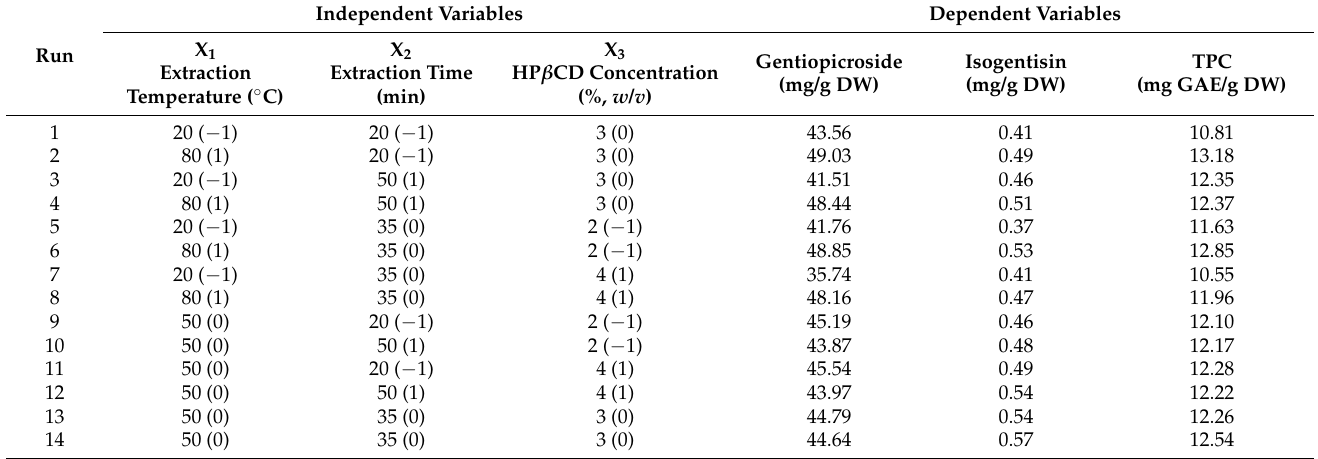
Table 1. Box–Behnken experimental design with three independent variables varied on three levels (coded as − 1, 0, and 1) and experimentally observed extraction yields of target compounds as dependent